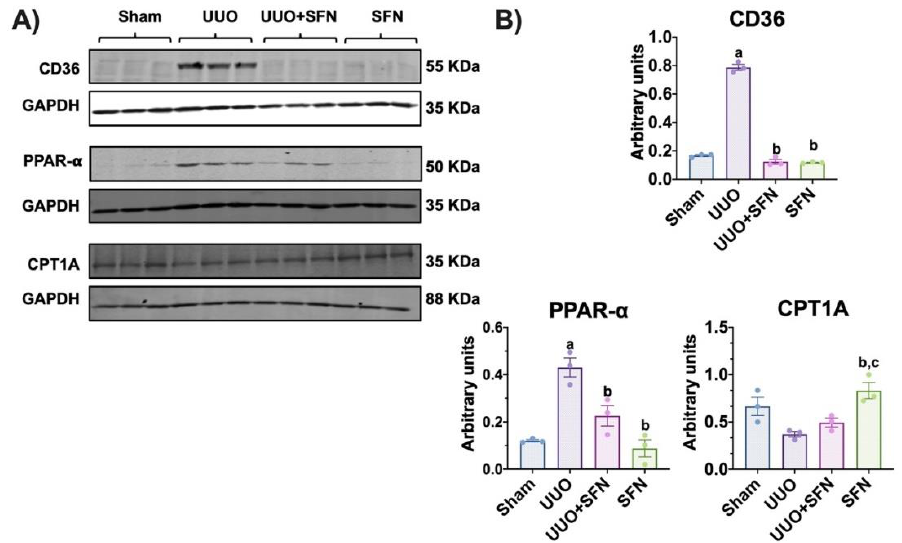
Figure 7. Effect of sulforaphane (SFN) on the uptake of fatty acids in the unilateral ureteral obstruction (UUO) model. ( A ) Representative immunoblotting and ( B ) densitometric analysis of cluster of differentiation 36 (CD36), peroxisome proliferator-activated receptor-alpha (PPAR- α), and carnitine palmitoyl transferase 1A (CPT1A). Data are mean ± SEM, n = 3 per group. Data were analyzed using one-way ANOVA and statistical differences were determined by multiple comparisons using Tukey’s test. Glyceraldehyde 3-phosphate dehydrogenase (GAPDH) was used as a loading control. a p < 0.05 vs. Sham, b p < 0.05 vs. UUO, c p < 0.05 vs. UUO + SFN. Sham: simulated surgery without ligation of the ureter; UUO: unilateral ureteral obstruction with double ligation of the left ureter for seven days; UUO + SFN: UUO treated with SFN (1 mg/kg, intraperitoneal); and SFN: administered with SFN (1 mg/kg, intraperitoneal).